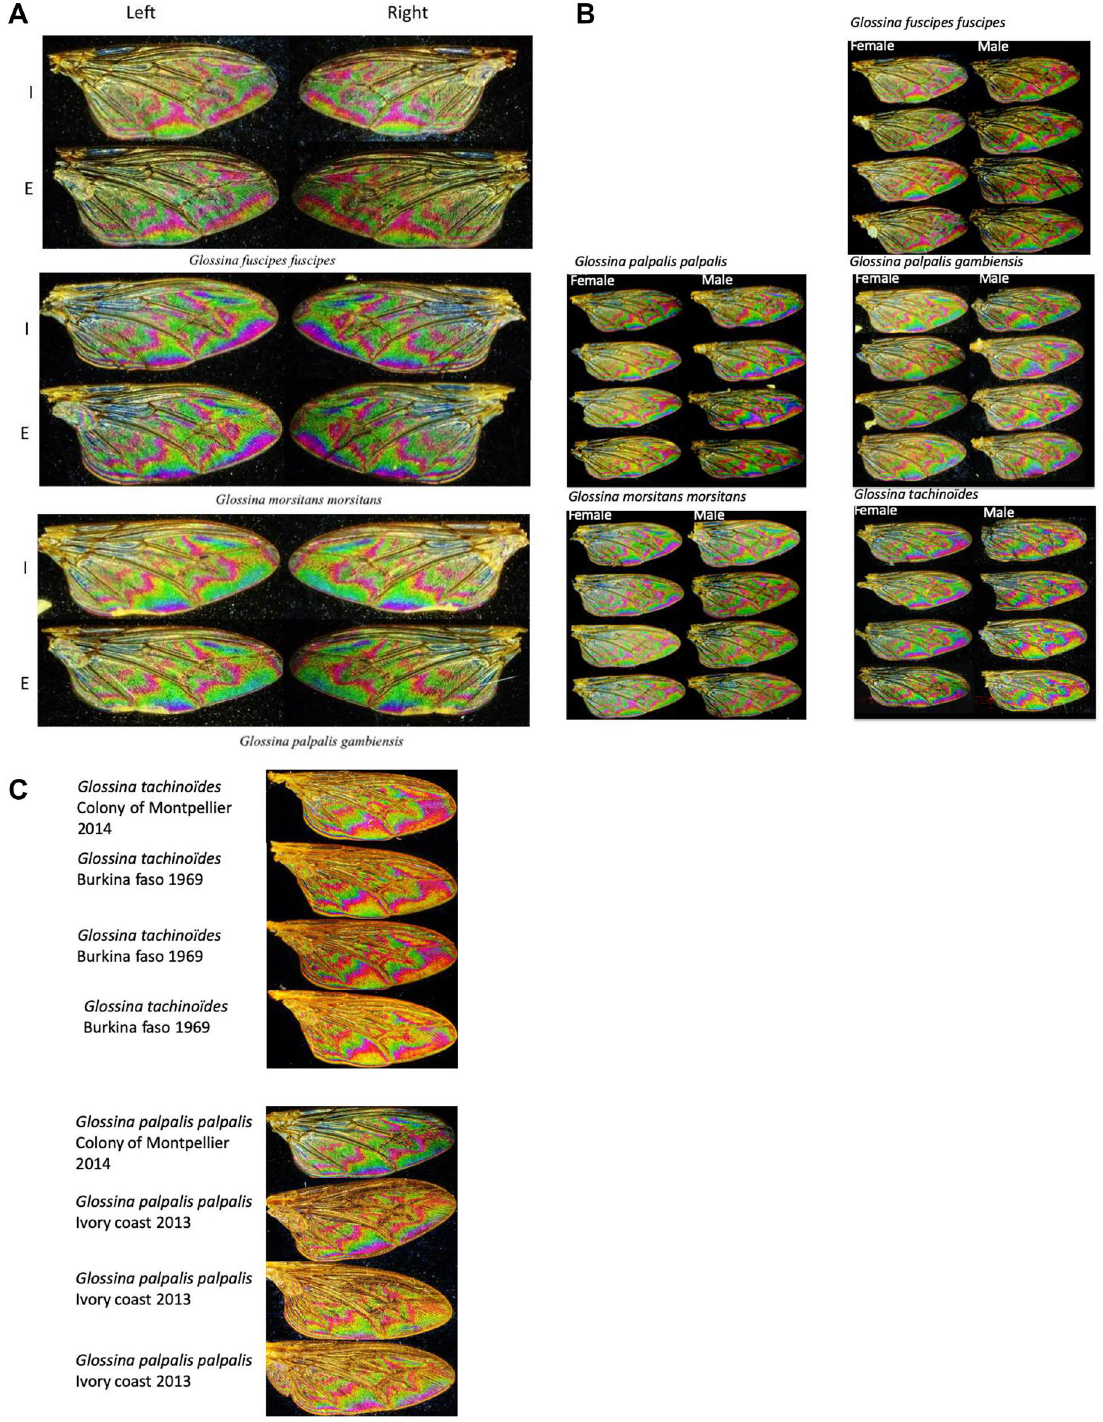
Figure 5. variability of WIPs generated on Glossina spp. according to ( A ) the wing orientation, top G. f. fuscipes , middle G. m. morsitans down G. p. gambiensis , ( B ) the samples, and ( C ) the preservation history. I, intrados and E,